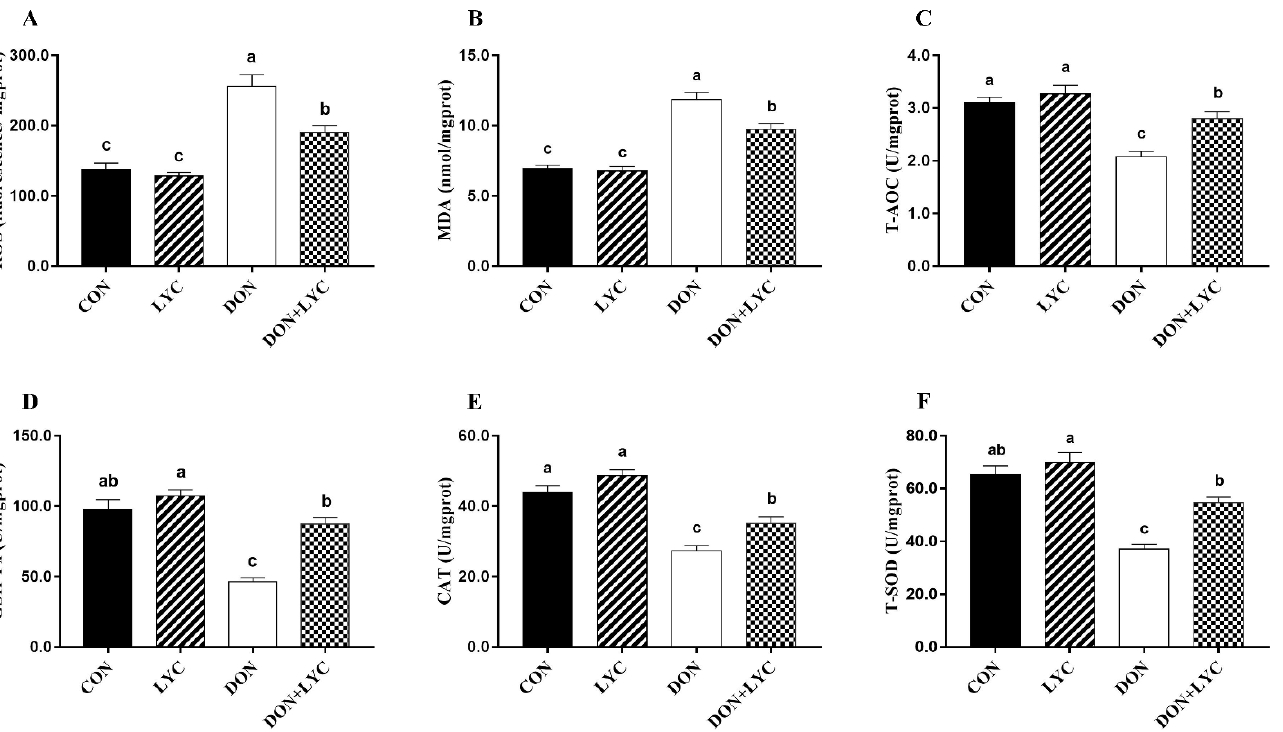
Figure 5. LYC treatment attenuated intestinal epithelium oxidative injury induced by DON. ( A ) Reactive oxygen species (ROS), ( B ) malondialdehyde (MDA), ( C ) total antioxidant capacity (T-AOC), ( D ) glutathione peroxidase (GSH-Px), ( E ) catalase (CAT), and ( F ) total superoxidase dismutase (T-SOD). Results are presented as mean ± SEM ( n = 6). Columns with different superscripts letters indicating significant difference ( p < 0.05).